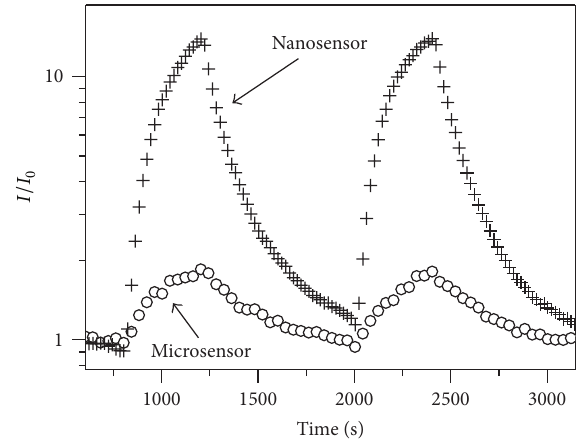
Figure 7: Normalized current sensing response of the TiO 2−𝑥 nano- sensor (crosses) and microsensor (open circles) to 1.5% H 2 concen- tration in dry air at 190 ∘ C. Both the nanosensor and the microsensor are respectively shown in Figures 1(h) and